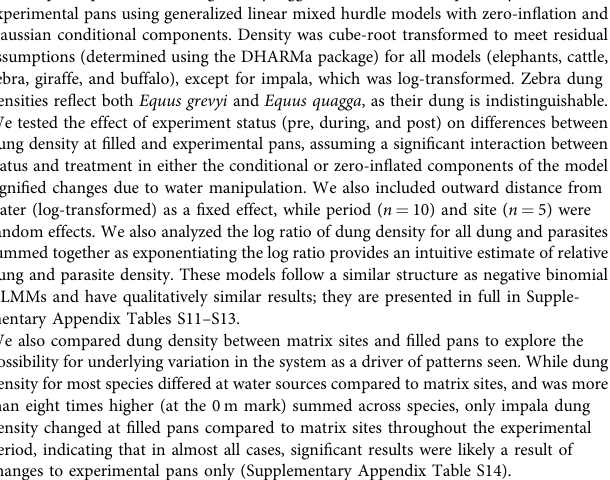
Fig. S3 and Table S5 for detailed dung volume measurement methods). After a drought in June 2017, quadrats were laid on both sides of the transect to increase the sampling area, and density was calculated by averaging across the two